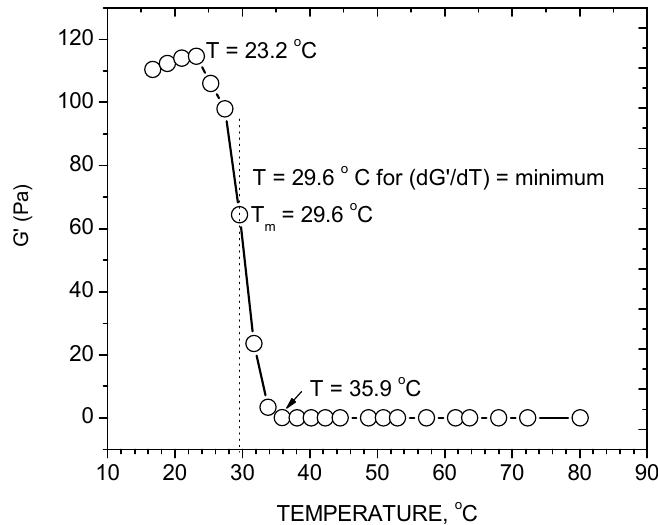
Figure 2. Rheological test for elastic modulus (G ′ ) of the gel obtained from treated dye solution (AB45) upon heating. The curve represents the variation of G ′ of the gel with temperature increasing from 15 to 80 °C.